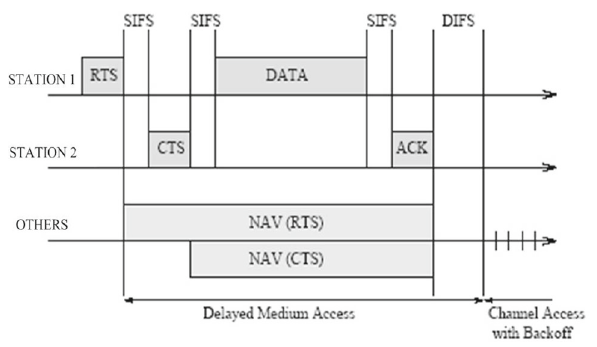
Fig. 2 Illustration of RTS/CTS and back-off mechanism of